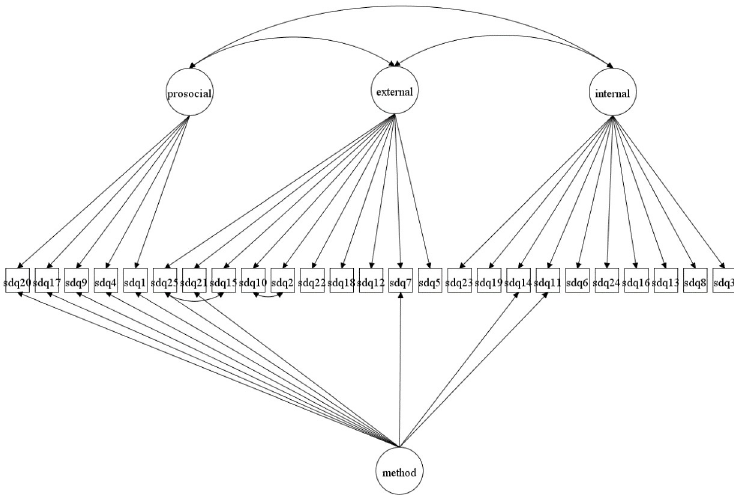
Fig 7. 3-factor model with a separate method factor and correlated errors for minor factors (Model 4b).